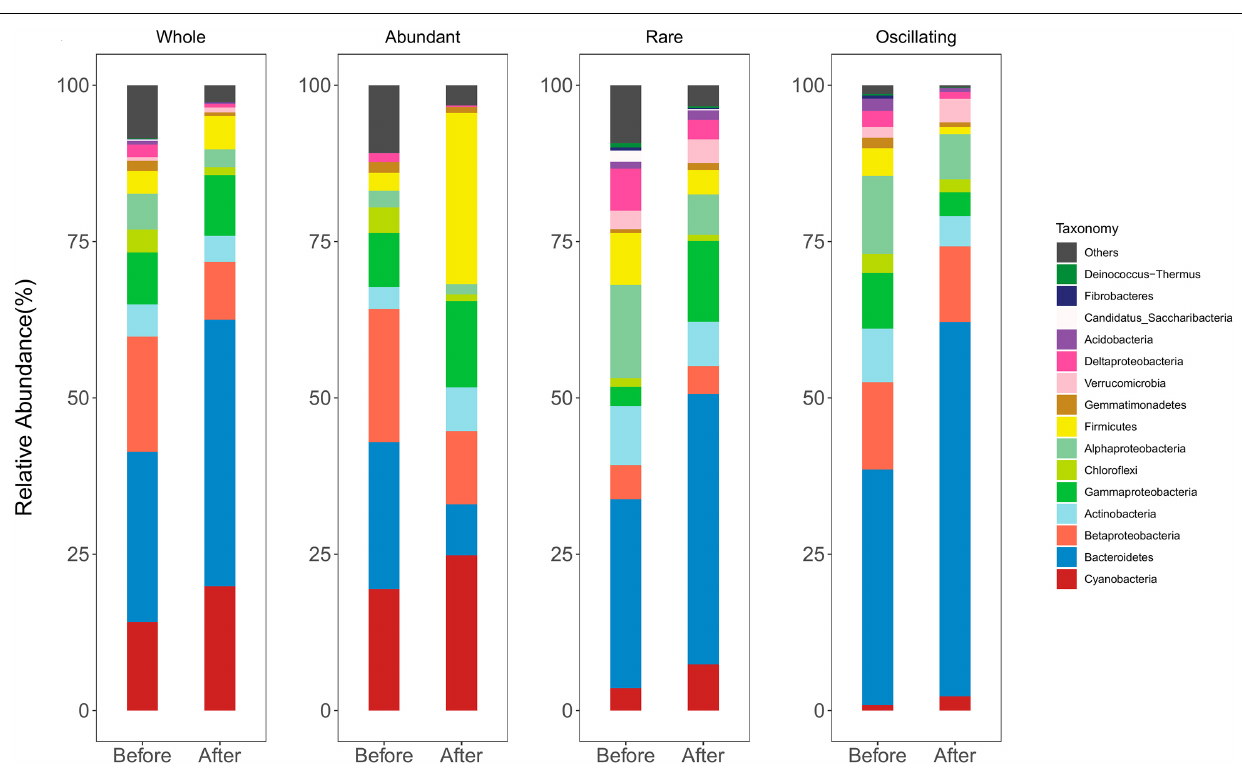
Frontiers in Microbiology |